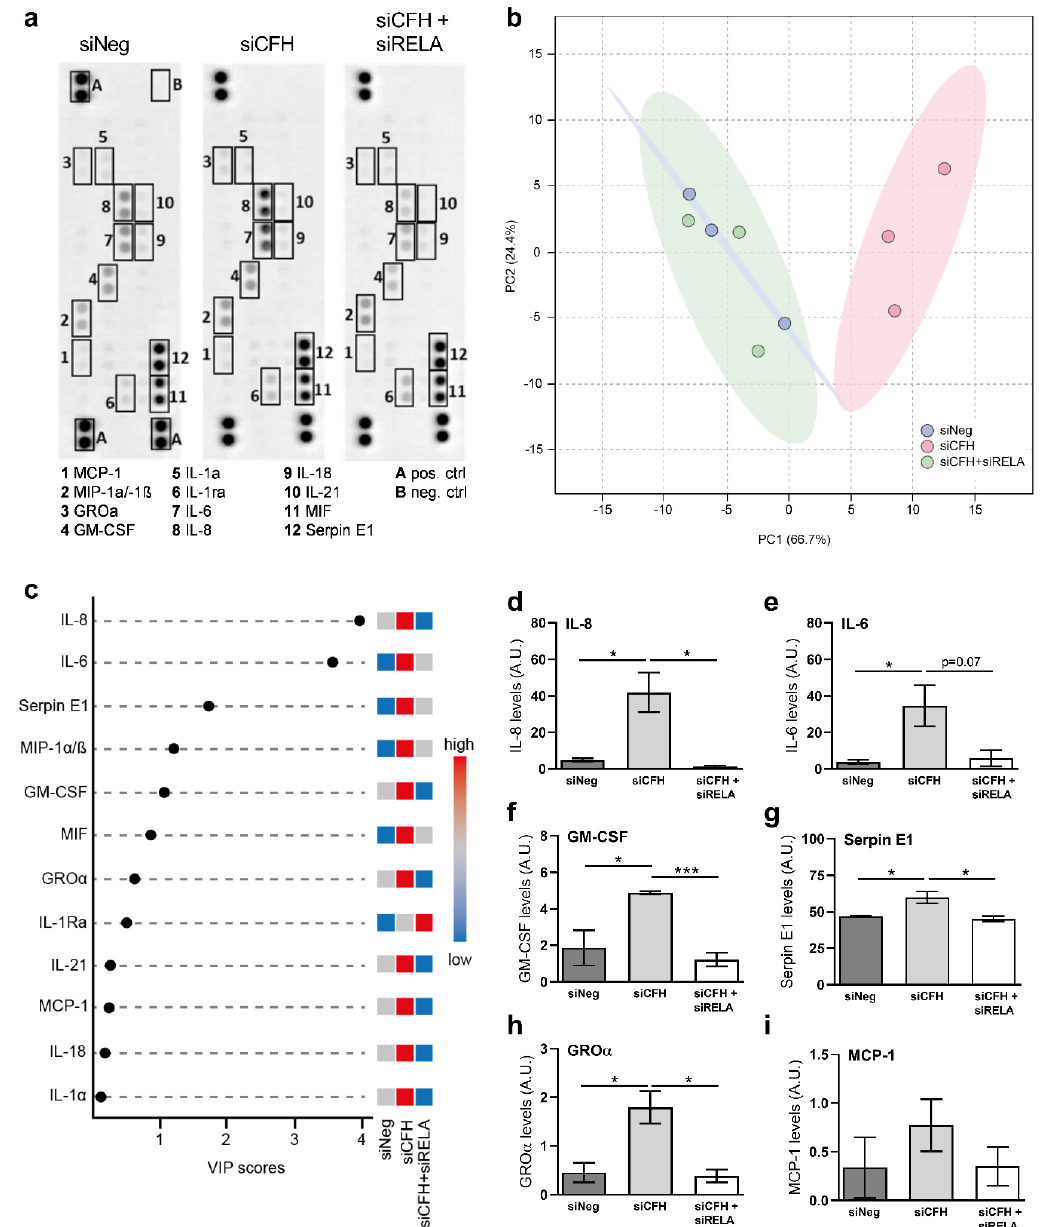
Figure 3. Blockade of NF- κ B abolishes the effects of FH loss on secreted cytokines. ( a ) Representative image of a Proteome Profiler Human Cytokine Array analysis performed on cell culture supernatants collected from hTERT-RPE1 cells after 48 h. ( b ) PCA Analysis of the Cytokine array data for all biological replicates, samples were colored according to the corresponding siRNA treatment group, 95% confidence regions were plotted and colored according to each group. ( c ) Variable importance in projection (VIP) score plot derived from PLS-DA analysis, the top cytokines that contribute to the segregation between the groups were plotted, and their differential abundance was color scaled according to their enrichment (red), depletion (blue), or unchanged (grey). ( d , i ) Quantification of the signal density in the conditions reported in a: ( d ) Interleukin-8, IL-8; ( e ) interleukin-6, IL-6; ( f ) colony stimulating factor 2, GM-CSF; ( g ) serpin family E member 1, Serpin E1; ( h ) C-X-C Motif Chemokine Ligand 1, CXCL1/GRO α ; i C-C Motif Chemokine Ligand 2,CCL2. SEM is shown. n = 3. Significance was assessed by a Student’s t -test. * p < 0.05, *** p < 0.001). negative control (siNeg), CFH specific siRNA (siCFH), RELA specific siRNA